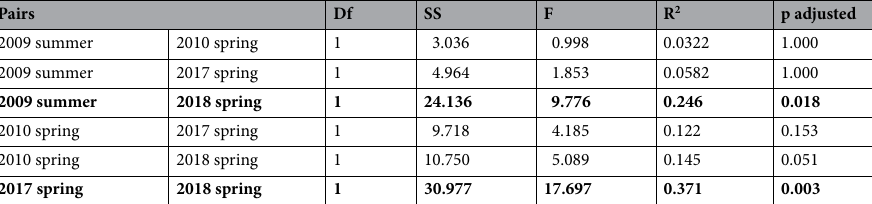
Table 1. Results of the pairwise comparisons of the reference data (summer 2009, spring 2010) and our data (spring 2017 and 2018) via PERMANOVA between years (p values are adjusted for multiple comparisons based on Bonferroni method, p < 0.05, bold: significant).